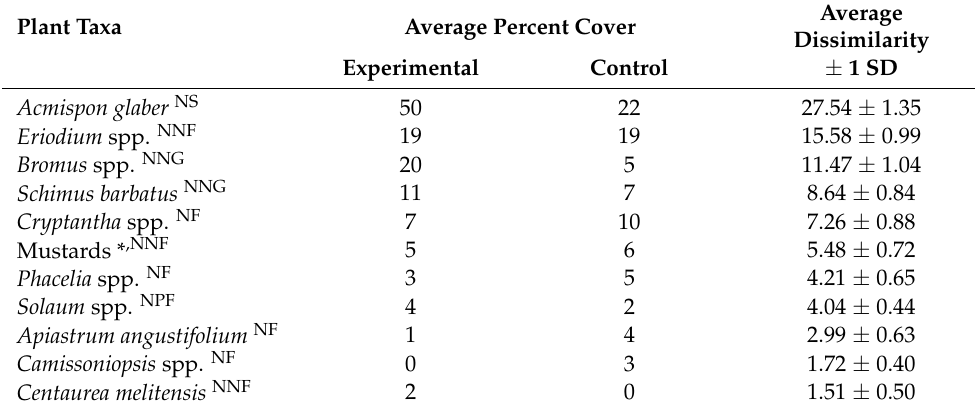
Table 1. Results from SIMPER analyses listing the most important species that contribute to dif- ferences in plant assemblages between experimental (herbivore excluded) and control (herbivore allowed) plots. Subscripts indicate a plant’s designation as either a native shrub (NS), native annual forb (NF), native perennial forb (NPF), non-native grass (NNG), or non-native annual forb (NNF).